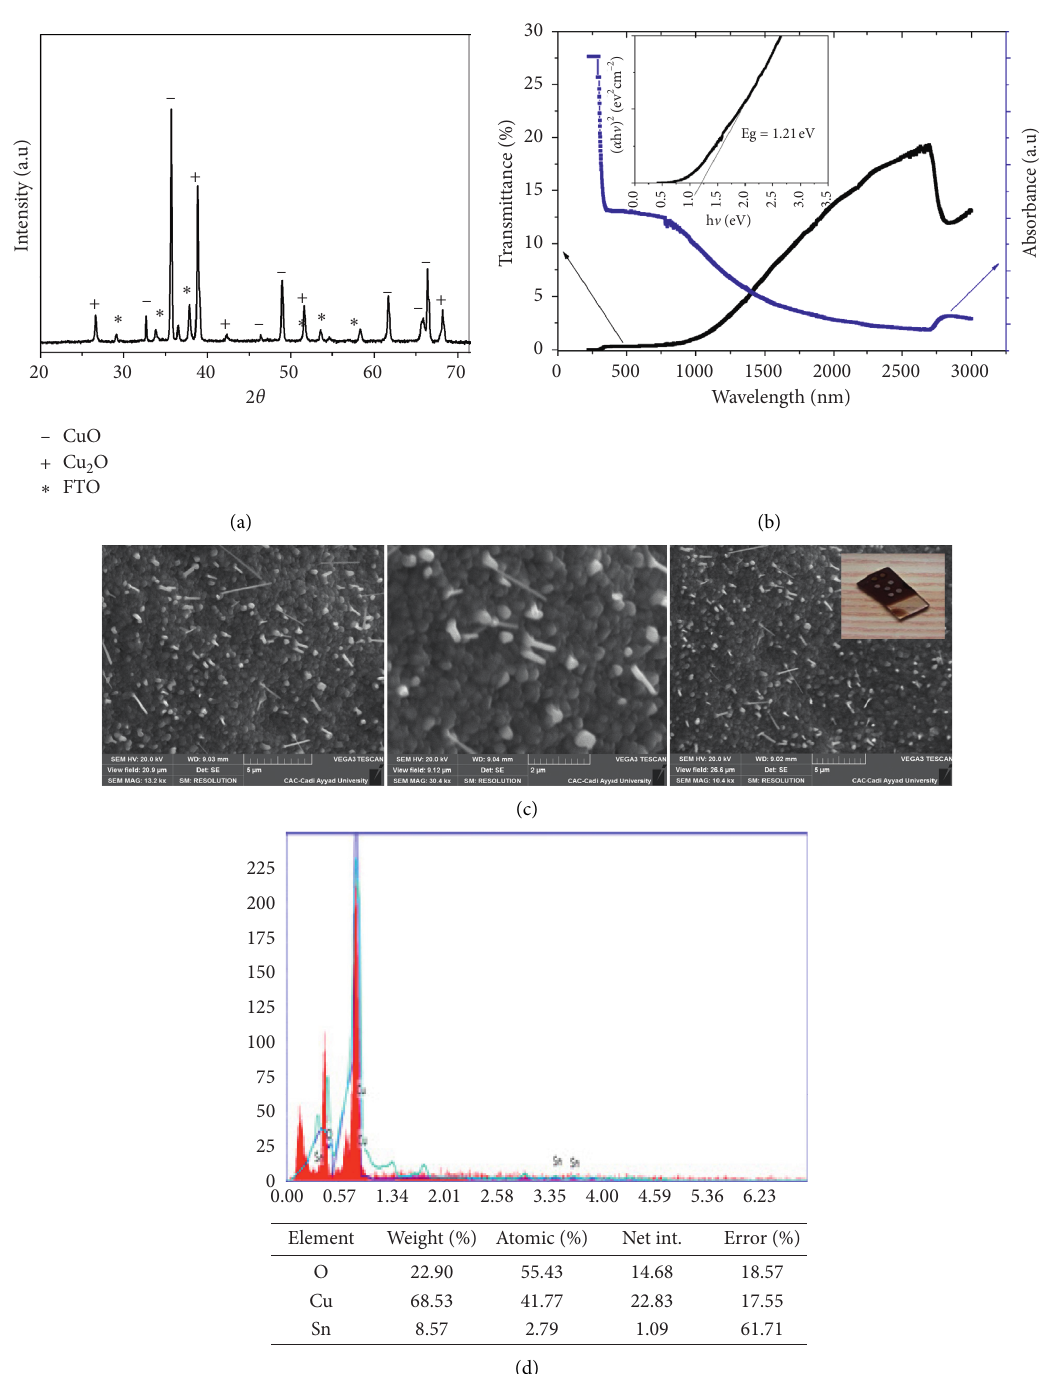
Figure 7: Data for the CuO NWs deposited on a thin copper film. (a) XRD patterns, (b) transmittance and absorbance data, (c) SEM images with a photo of a sample in the inset, and (d) EDX analysis for the sample obtained on the thin copper